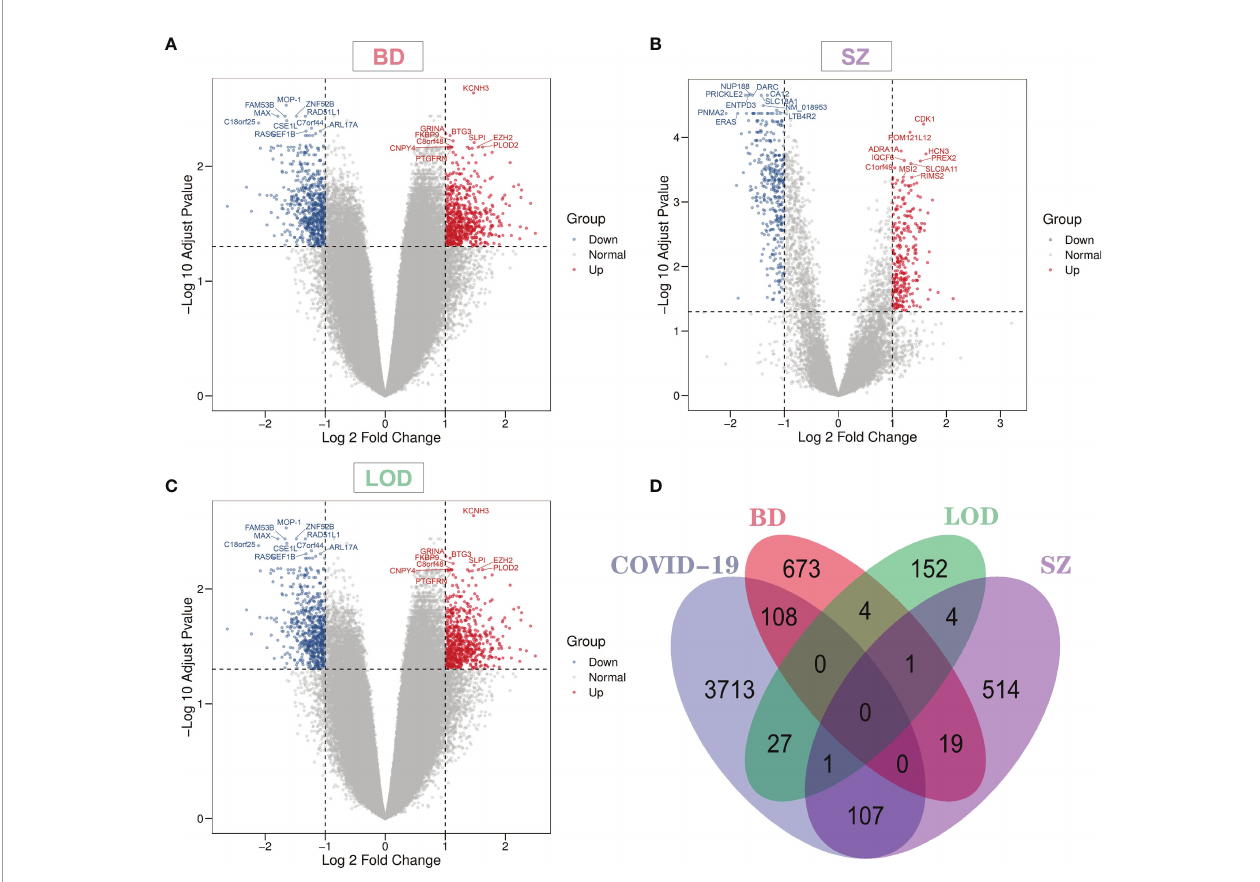
FIGURE 1 | Volcano plots indicate differentially expressed genes (DEGs) of (A) bipolar disorder (BD), (B) schizophrenia (SZ), and (C) late-onset major depressive disorder (LOD), with genes harboring log fold-change of at least 1 and adjusted P -value <0.05. The Venn diagram depicts the shared DEGs among coronavirus disease 2019 (COVID-19) and (D) BD, SZ, and